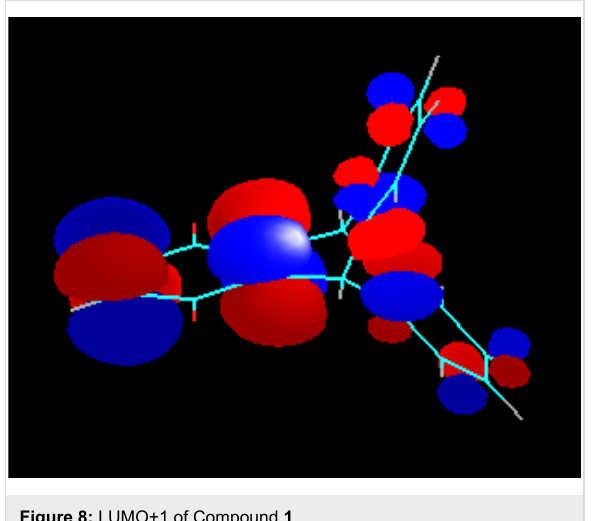
Figure 10: LUMO+1 of Compound 2 .